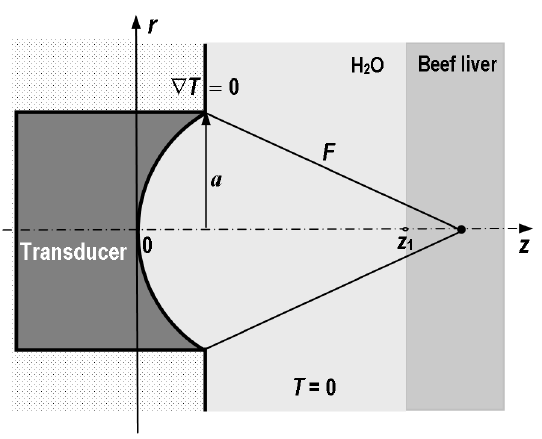
Figure 1. Geometric scheme of a two-layer system of media (water/beef liver) for predicting both, the acoustic pressure and temperature fields induced therein by pulsed focused ultrasonic